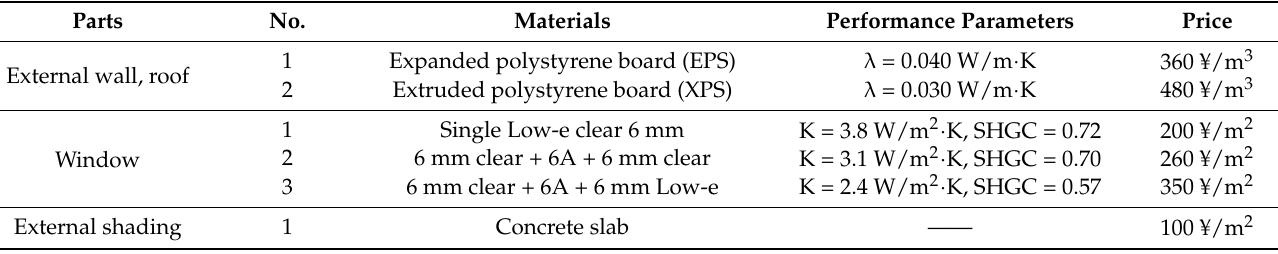
Table 11. The investment costs of different design